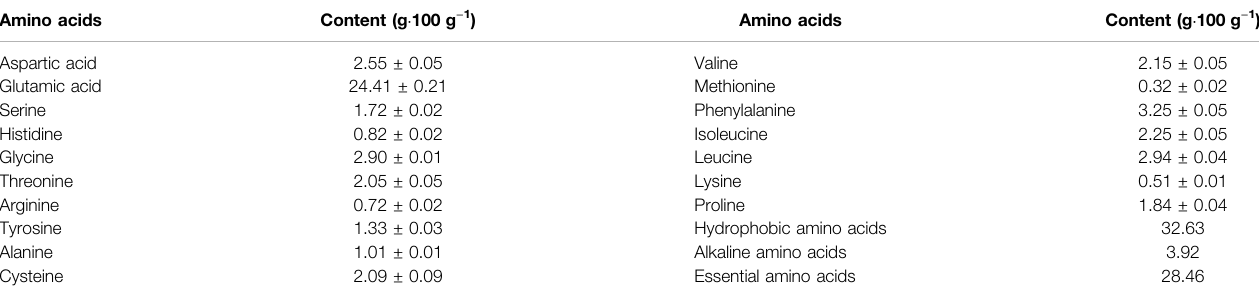
TABLE 1 | Amino acid composition of fraction G1. Amino